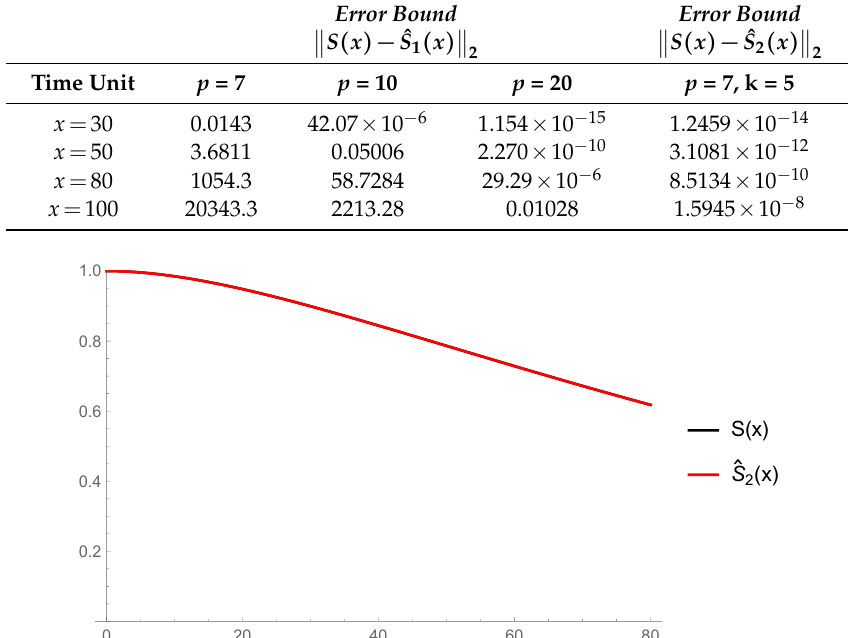
Figure 3. Survival function, S ( x ) , and the second approximation, ˆ S 2 ( x ) , in the concatenated Markov process for k = 5 and p = 7 with simulated data from a uniform